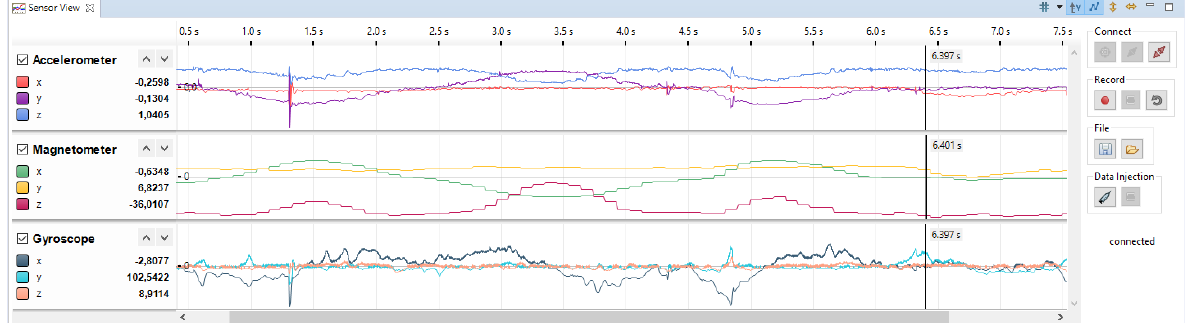
Figure 6. Sensor View in Eclipse